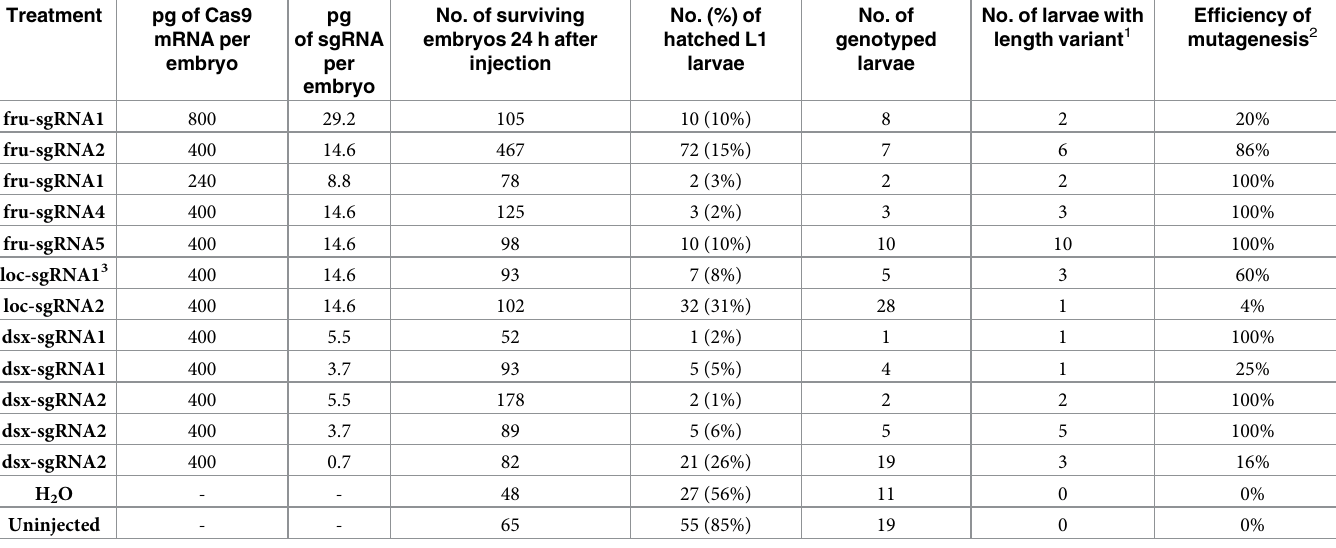
Table 1. Frequency of the mutated honeybee larvae based on FL analyses at single base-pair resolution of the amplicons. Treatment pg of Cas9 mRNA per